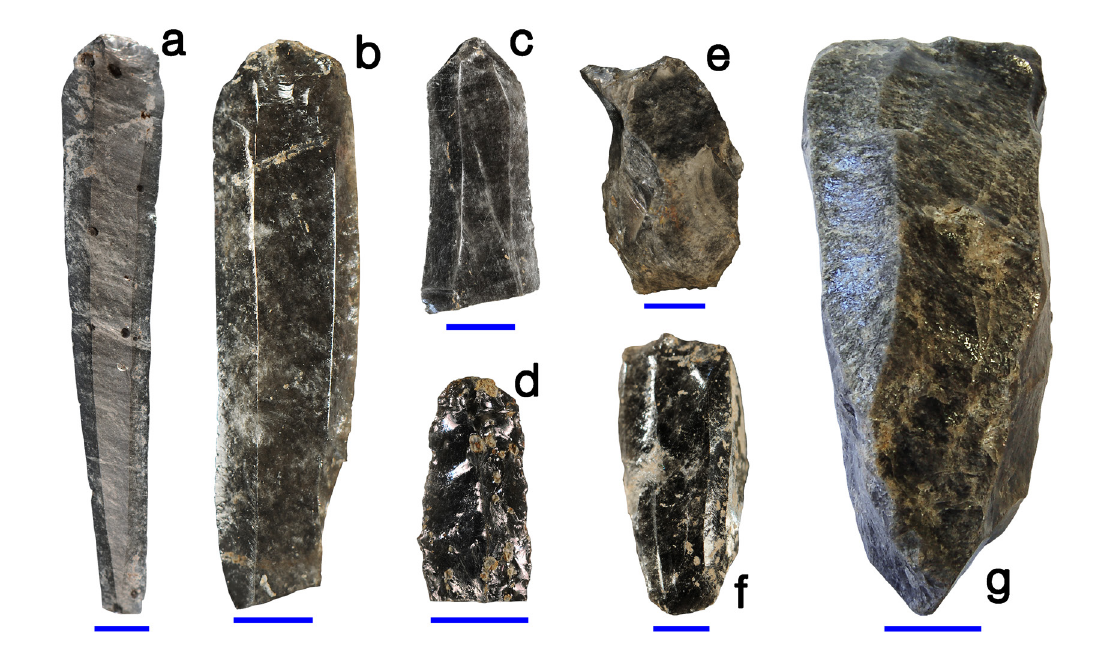
Figure 2: Photographs of the obsidian finds from the underground examined karstic sites; a–d : flakes and blades, intact and fragmentary ( a–b from Grotta di Santa Barbara; c–d from Grotta del Tesauro); e : punch on splinter from Grotta della Monaca; f–g : cores for detachment of slats and blades ( f from Grotta di Santa Barbara; g from Grotta di Polla) (photographs by F. Larocca & A. Di Meo). Blue scale bar is 1